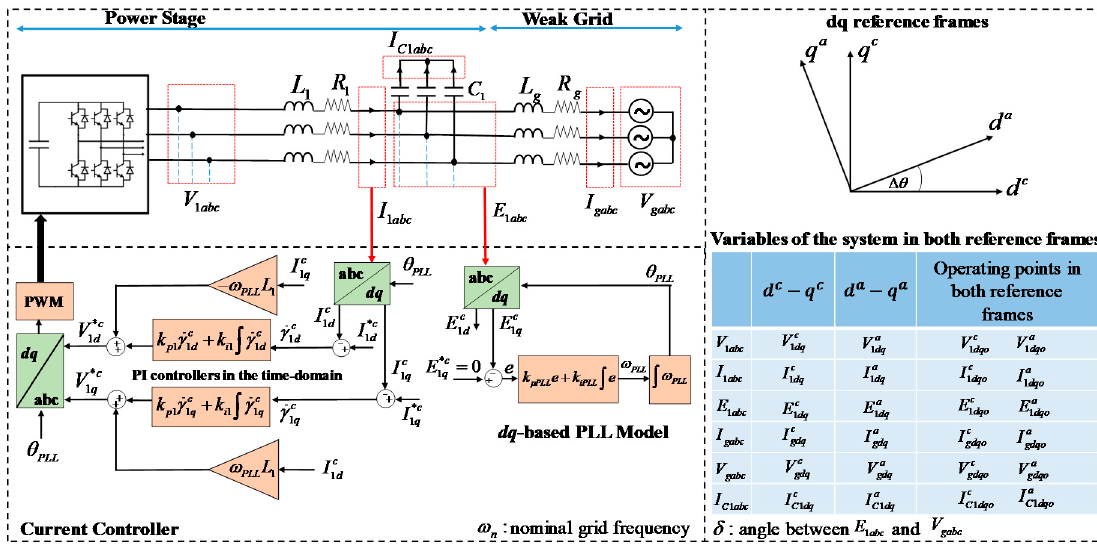
Figure 3. Current-controlled grid connected three-phase three-wire converter using a dq -PLL.